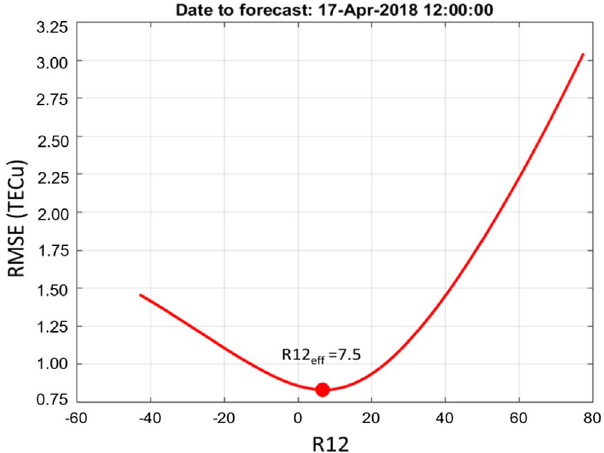
Fig. 6. Example of the relationship between RMSE and R12 for 17 April 2018 at noon. Red dot represents the retrieved